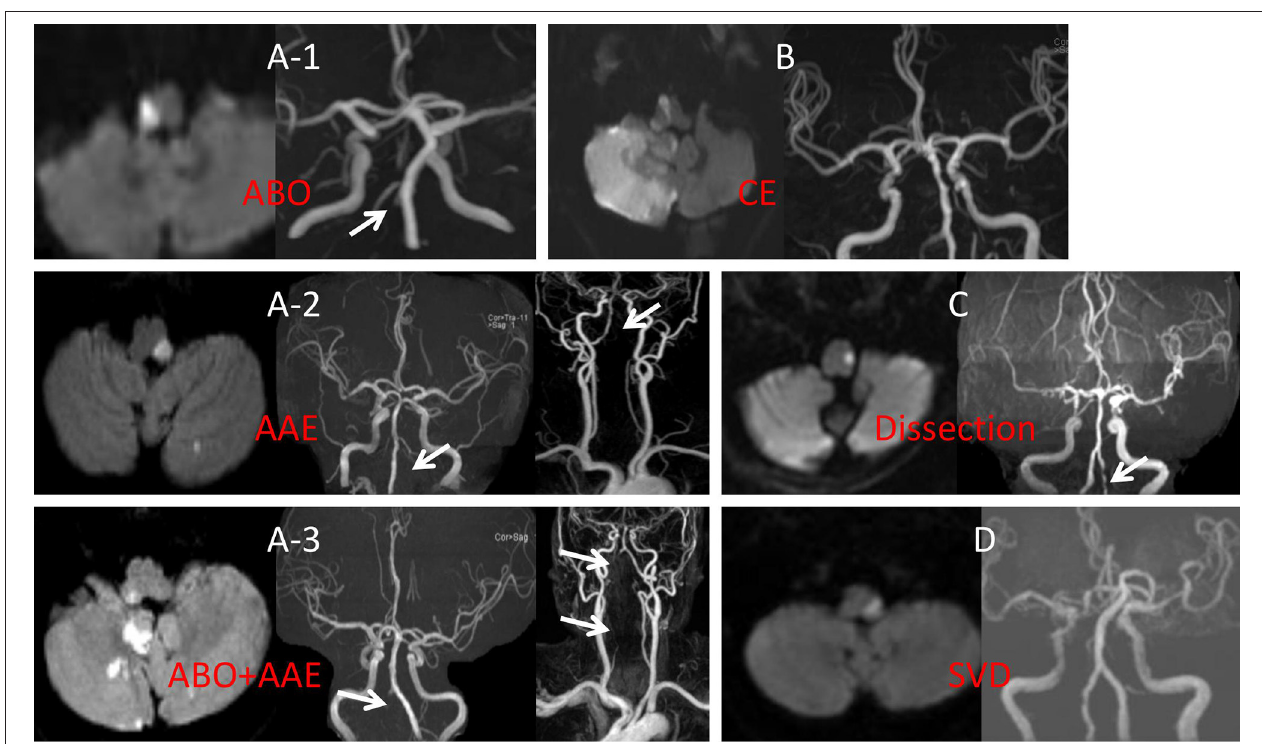
FIGURE 1 | (A-1) DWI showed right caudal medullary infarction, MRA showed right intracranial VA occlusion. (A-2) DWI indicated left middle medullary and cerebellar infarction, MRA showed occlusion in the proximal left VA with no distal VA disease. (A-3) DWI showed right rostral medullary and cerebellar multiple infarction, MRA showed in both distal and proximal right VA. (B) DWI showed the right rostral medullary and cerebellar multiple infarction, MRA showed bilateral VA was normal. (C) DWI showed caudal medullary infarction, MRA showed the pearl, and string sign of left VA. (D) DWI showed middle medullary infarction, MRA showed the bilateral VA were normal. ABO, atheromatous branch occlusion; AAE, artery-to-artery embolism; CE, cardiogenic embolism; SVD, small vessel disease; DWI, diffusion weighted imaging; MRA, magnetic resonance angiography; VA, vertebral